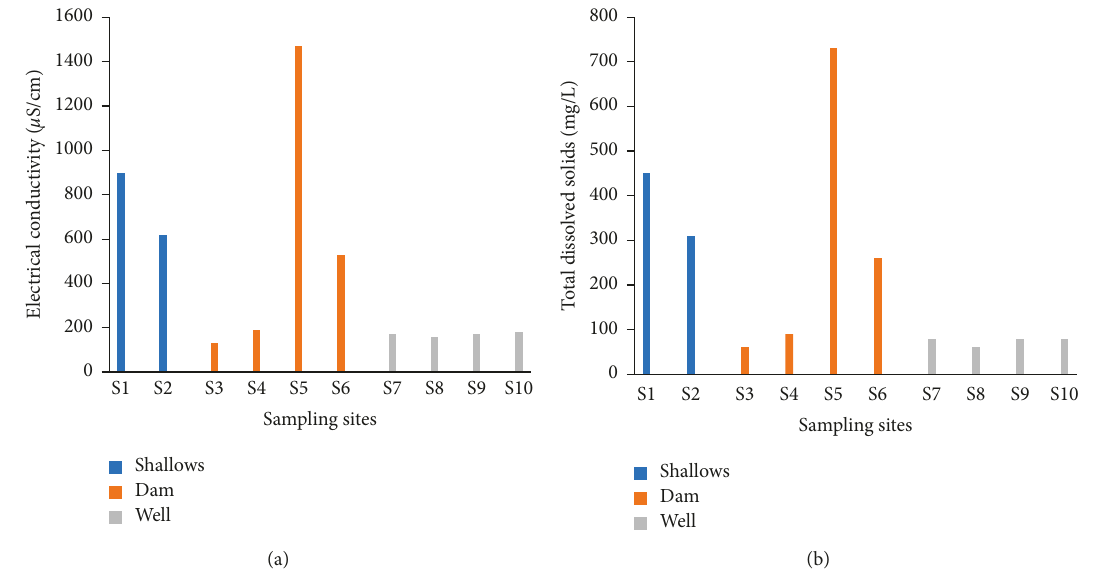
Figure 8: Electrical conductivity (a) and total dissolved solids (b) of irrigation water.